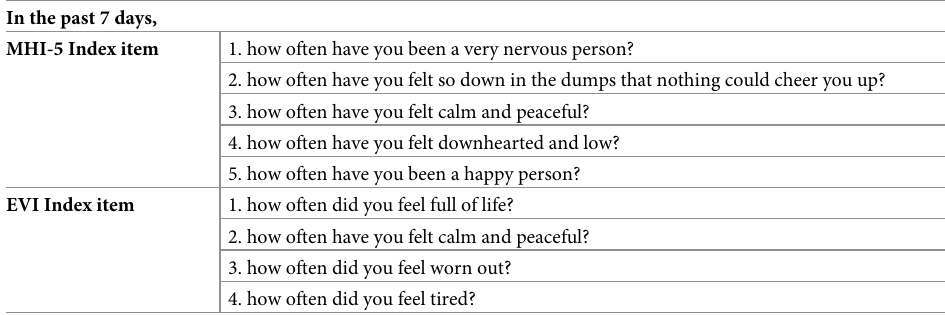
Table 1. MHI-5 and EVI